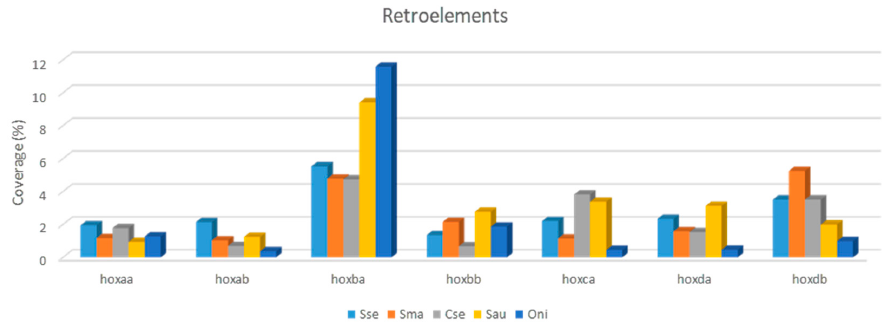
Figure 2. Coverage (%) of retroelements in seven hox clusters of five fish species: Solea senegalensis , Scophthalmus maximus , Cynoglossus semilaevis , Sparus aurata , and Oreochromis niloticus . Coverage is measured as the percentage of length occupied by repeated elements.